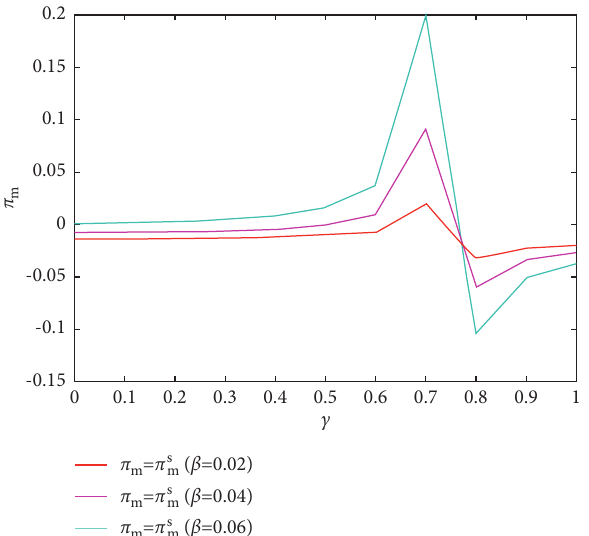
Figure 5: Effect of c on the profit of the